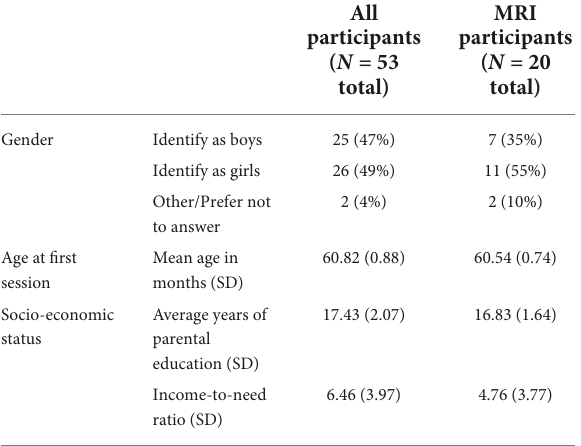
TABLE 2 Demographic information of the total and smaller samples.